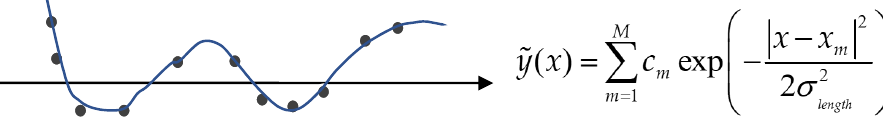
Figure A11. The architecture of Extreme Learning Machine. Appendix B